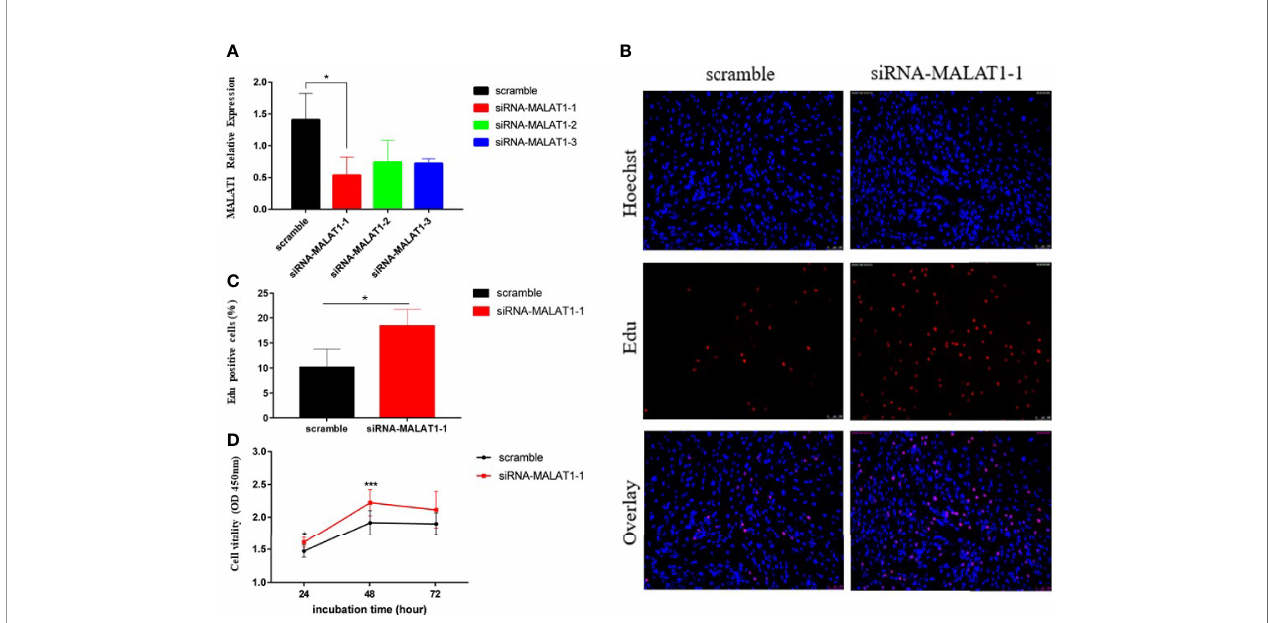
FIGURE 2 | Knockdown of MALAT1 promoted KGN cell proliferation. (A) Graph showing the expression level of MALAT1 in KGN cells treated with three different siRNA sequences via RT-qPCR (* p < 0.05). (B) Graphs showing the proportion of proliferation cells via Edu assay in granulosa cells treated with the most ef fi cient siRNA sequence in (A) . The amount of cells was detected by staining with Hochest (blue), as the proliferated cells were detected by staining with EdU (red). The result was analyzed by fl uorescence microscope. (C) Graph showing the percentages of EdU-positive cells (* p < 0.05). (D) Graph showing the viability of KGN cells treated with siRNA-MALAT-1 was measured by using Cell Counting Kit-8 at the indicated time points (* p < 0.05; *** p <